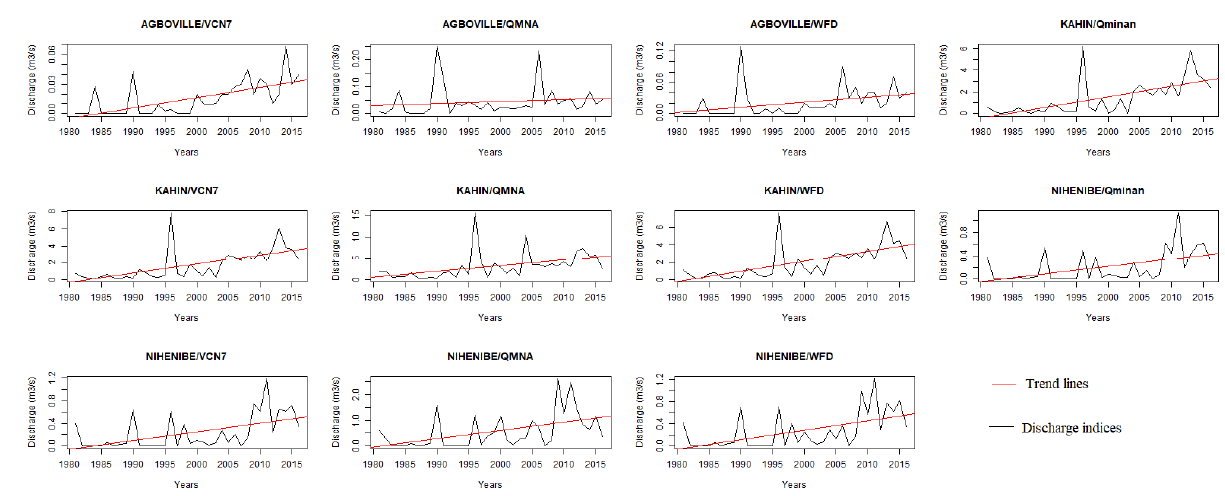
Figure A1. Homogeneous break point for VCX30 index.